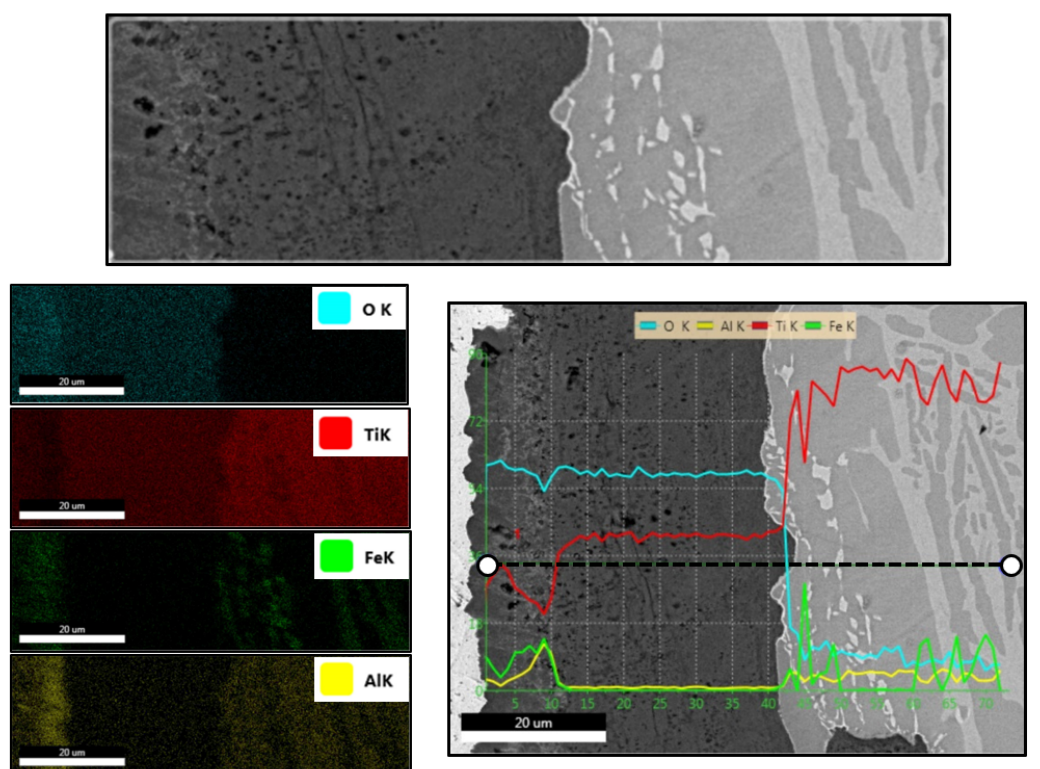
Figure 10. Results of the EDS area and linear mapping (at %) conducted on Ti-7Fe-3Al samples oxidized for 300 h at 600 °C.